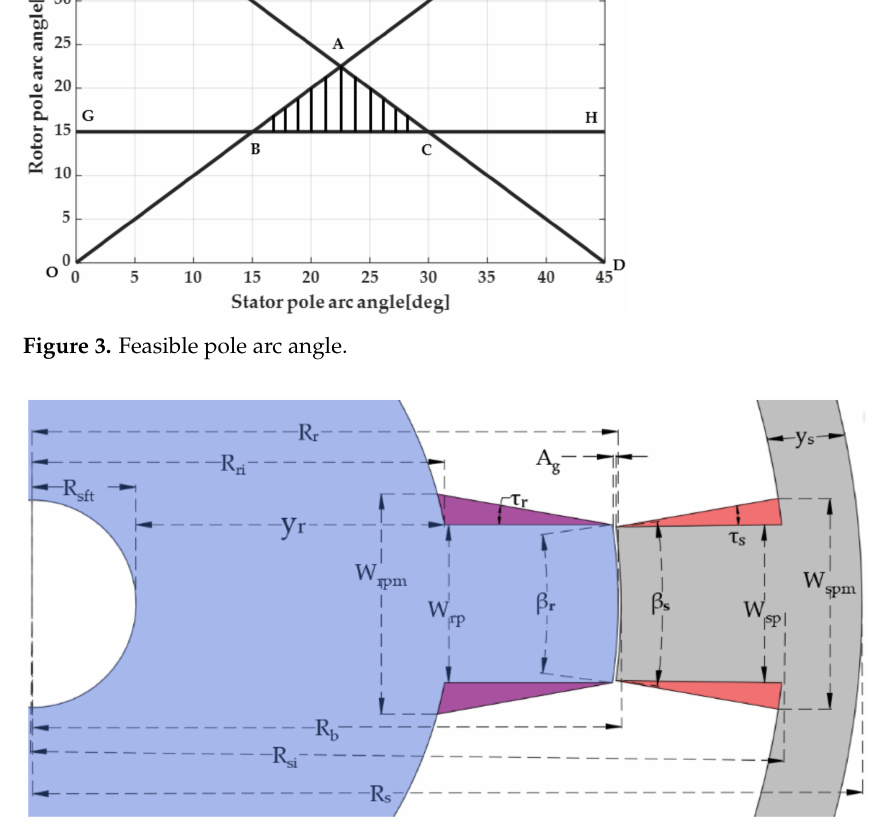
Figure 4. Notations of stator and rotor